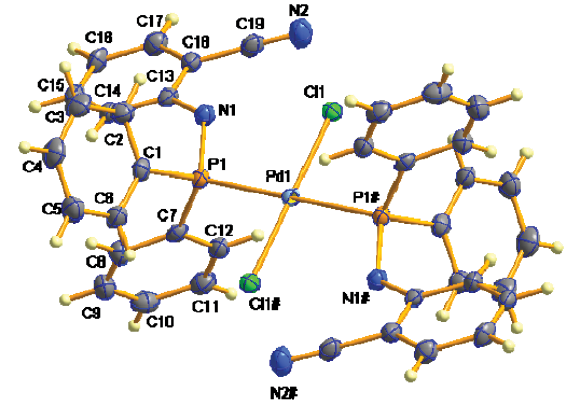
Figure 1. Ortep representation of 2 ∙2(CH Cl ); atoms are repre- 2 2 sented by ellipsoids at 50% probability level. Key bond distances ( Ǻ ) and angles (°) Pd1-Cl1, 2.3195(9); Pd1- P1, 2.3552(9); P1-N1, 1.697(3); P1-C1, 1.827(4); P1- C7, 1.828(4); N1-C13, 1.431(5); C19-N2, 1.152(5); Cl1- Pd1-P1, 93.41(3); Cl1-P1-P1#, 86.59(3); C18-C19-N2, 178.5(4). Demarcated atoms (#) are obtained by the symmetry operation 1-x, -y+1, -z. Dichloromethane sol- vent molecules omitted for